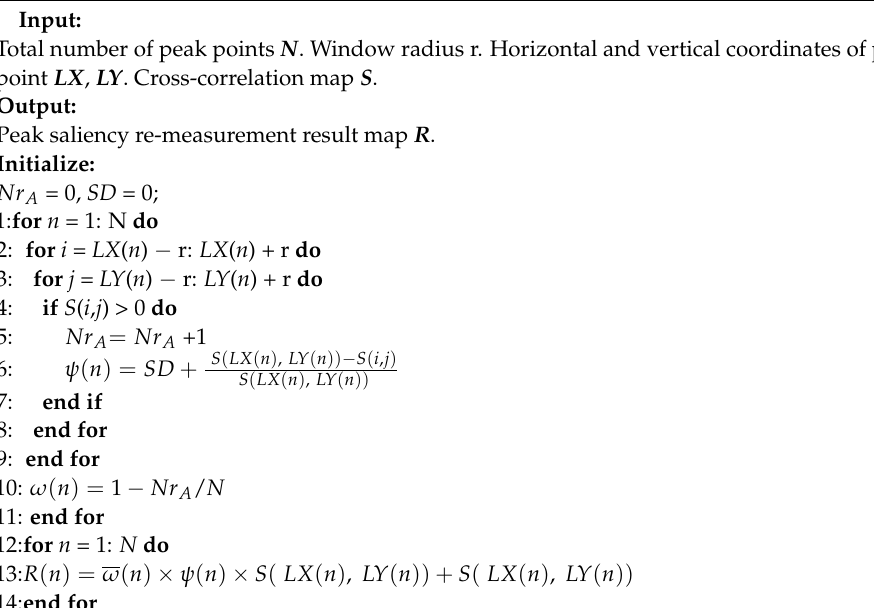
Algorithm 3: Peak saliency re-measurement and binary segmentation